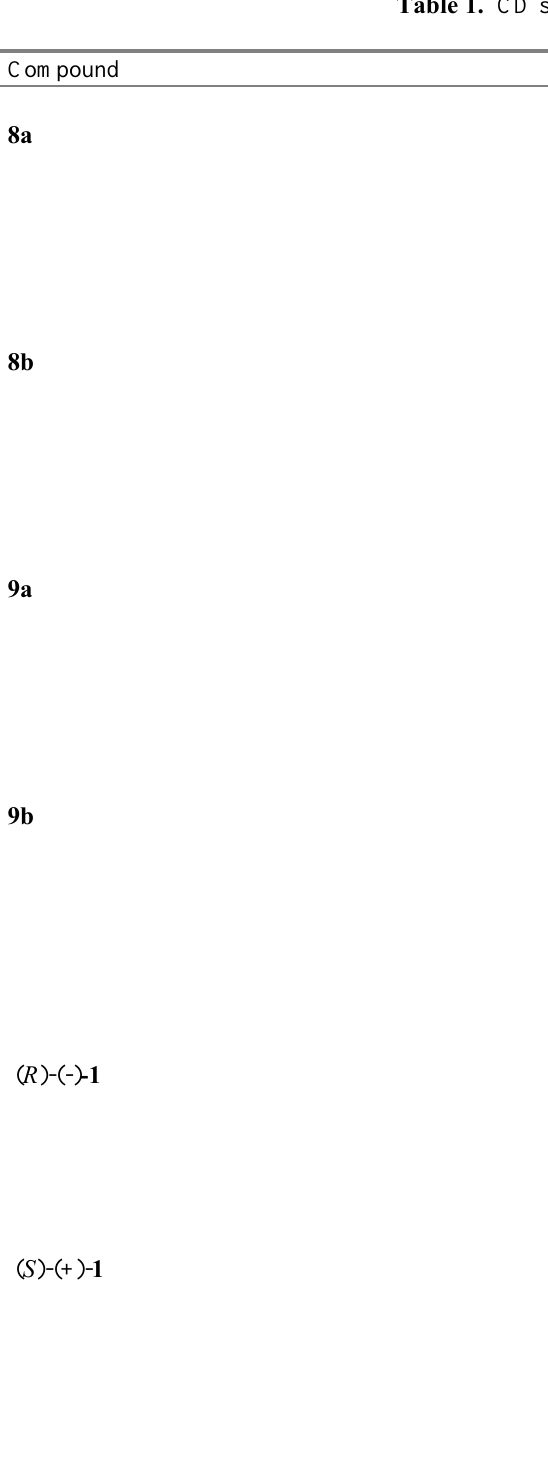
Table 1. CD spectral Data in